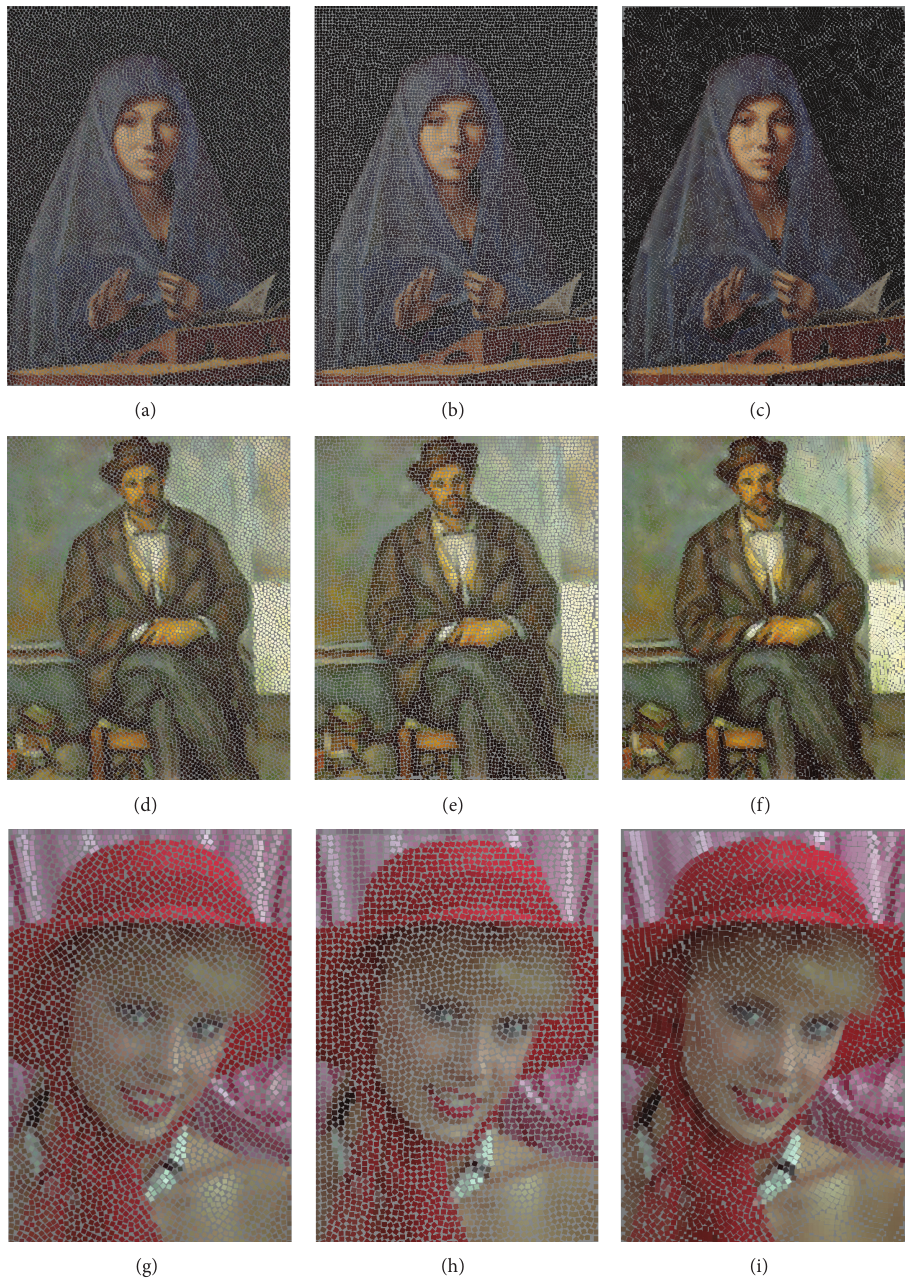
Figure 11: Visual comparisons of artificial mosaic techniques—our approach on the left (a, d, g), Liu et al. [25] in the middle (b, e, h), and Di Blasi and Gallo [22] on the right (c, f,